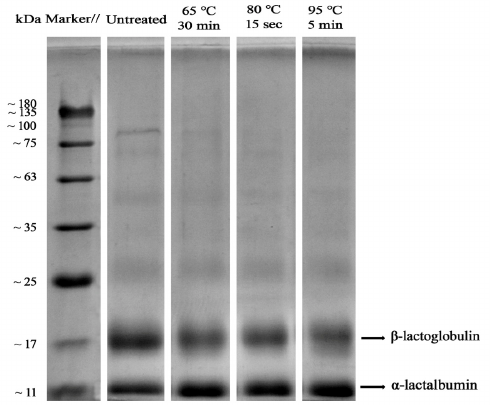
Figure 1. SDS-PAGE analysis of WPI with different sterilizations.